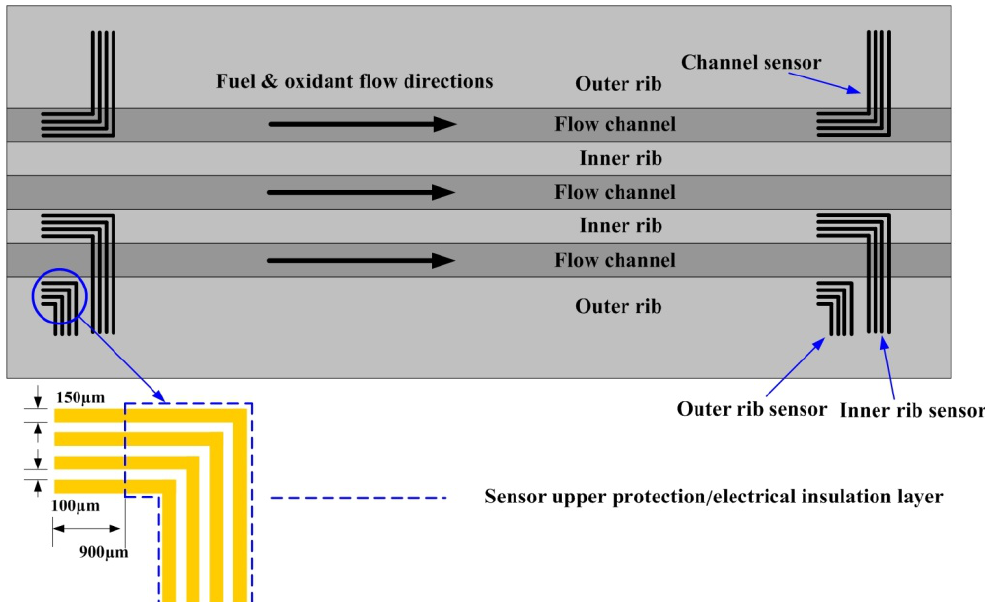
Figure 2. Design of dedicated novel sensors.